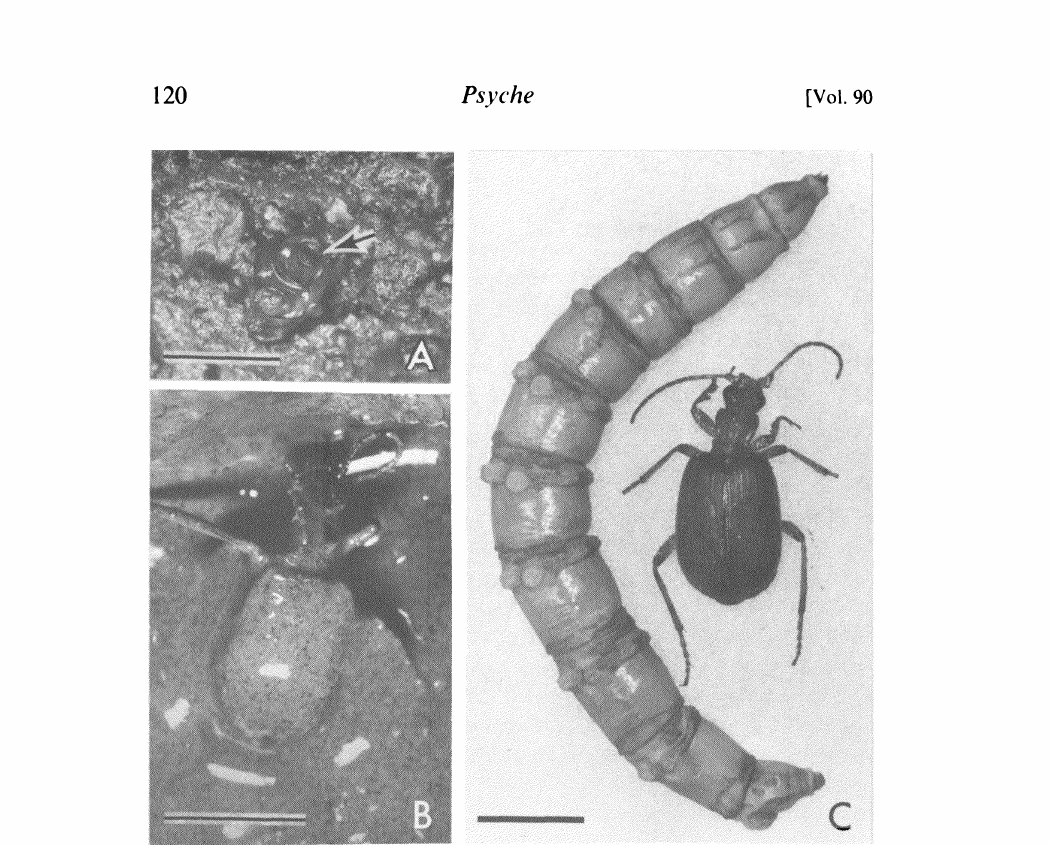
Figure I. (A) Mouthparts (arrow) of a buried T. punct(/’er larva, projecting just above the surface of the mud, as the animal lies in wait of prey. (B) Bombardier beetle, caught by a submerged larva and partly drawn into the mud, in the process of being eaten (the larvae can also pull beetles into drier mud than here shown). (C) Full grown T. punct(/’er larva beside an average-sized bombardier beetle. Reference bars 5